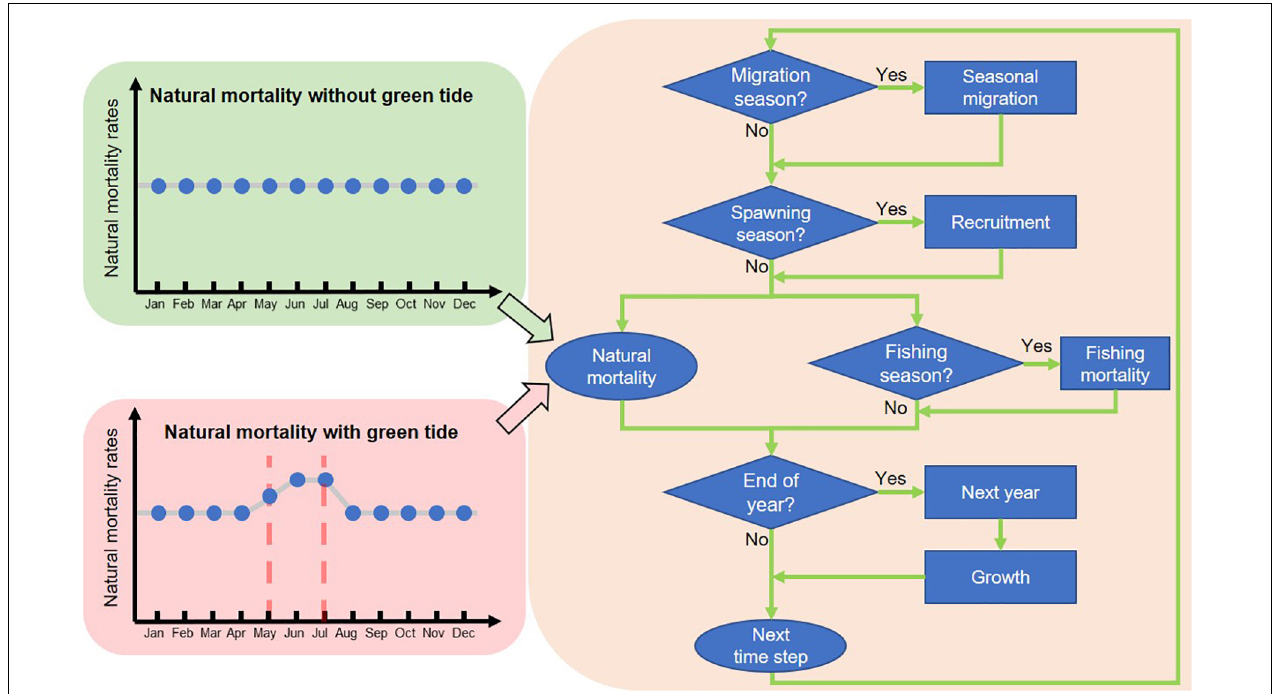
FIGURE 3 | Flowchart of the simulation framework used in this study. The framework is connected by three models and the components under them. Two types of natural mortality pattern are simulated in this study to mimic the population dynamics unimpacted (green panel) and impacted by the green tide (red panel).